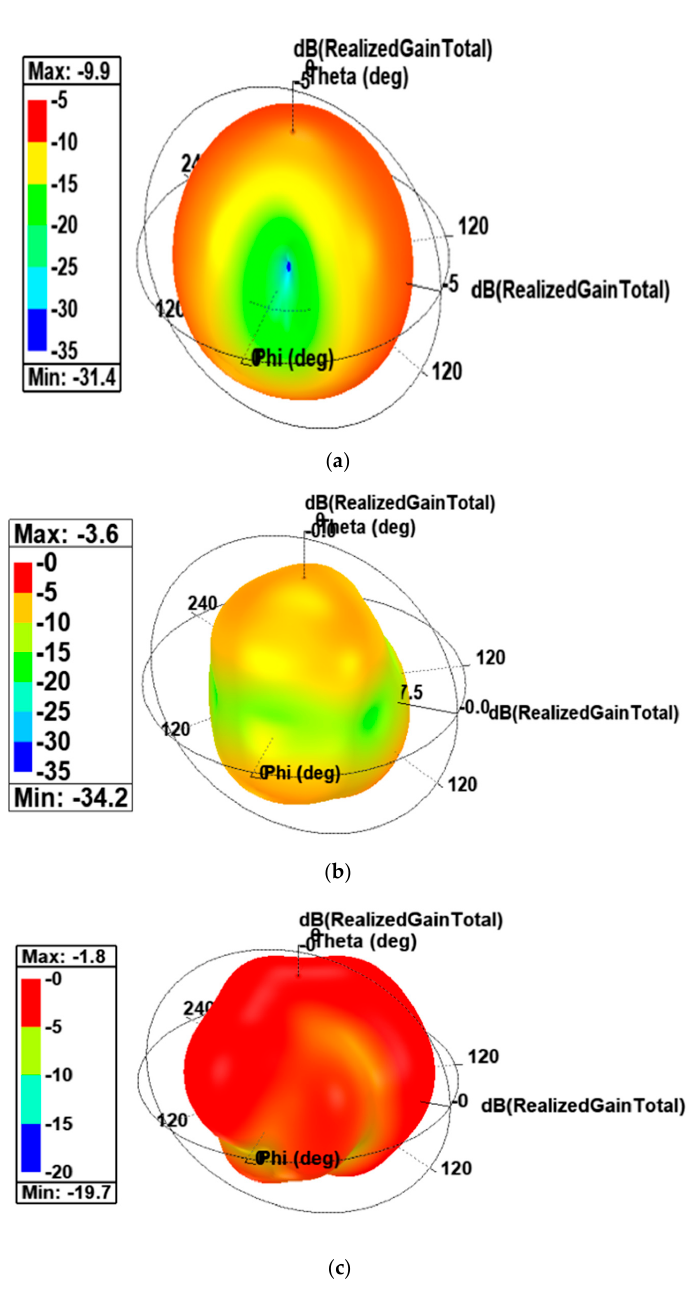
Figure 12. Three-dimensional polar gain plot for the designed antenna at notch frequency ( a ) 2 GHz, ( b ) 6 GHz, and ( c ) 10 GHz.